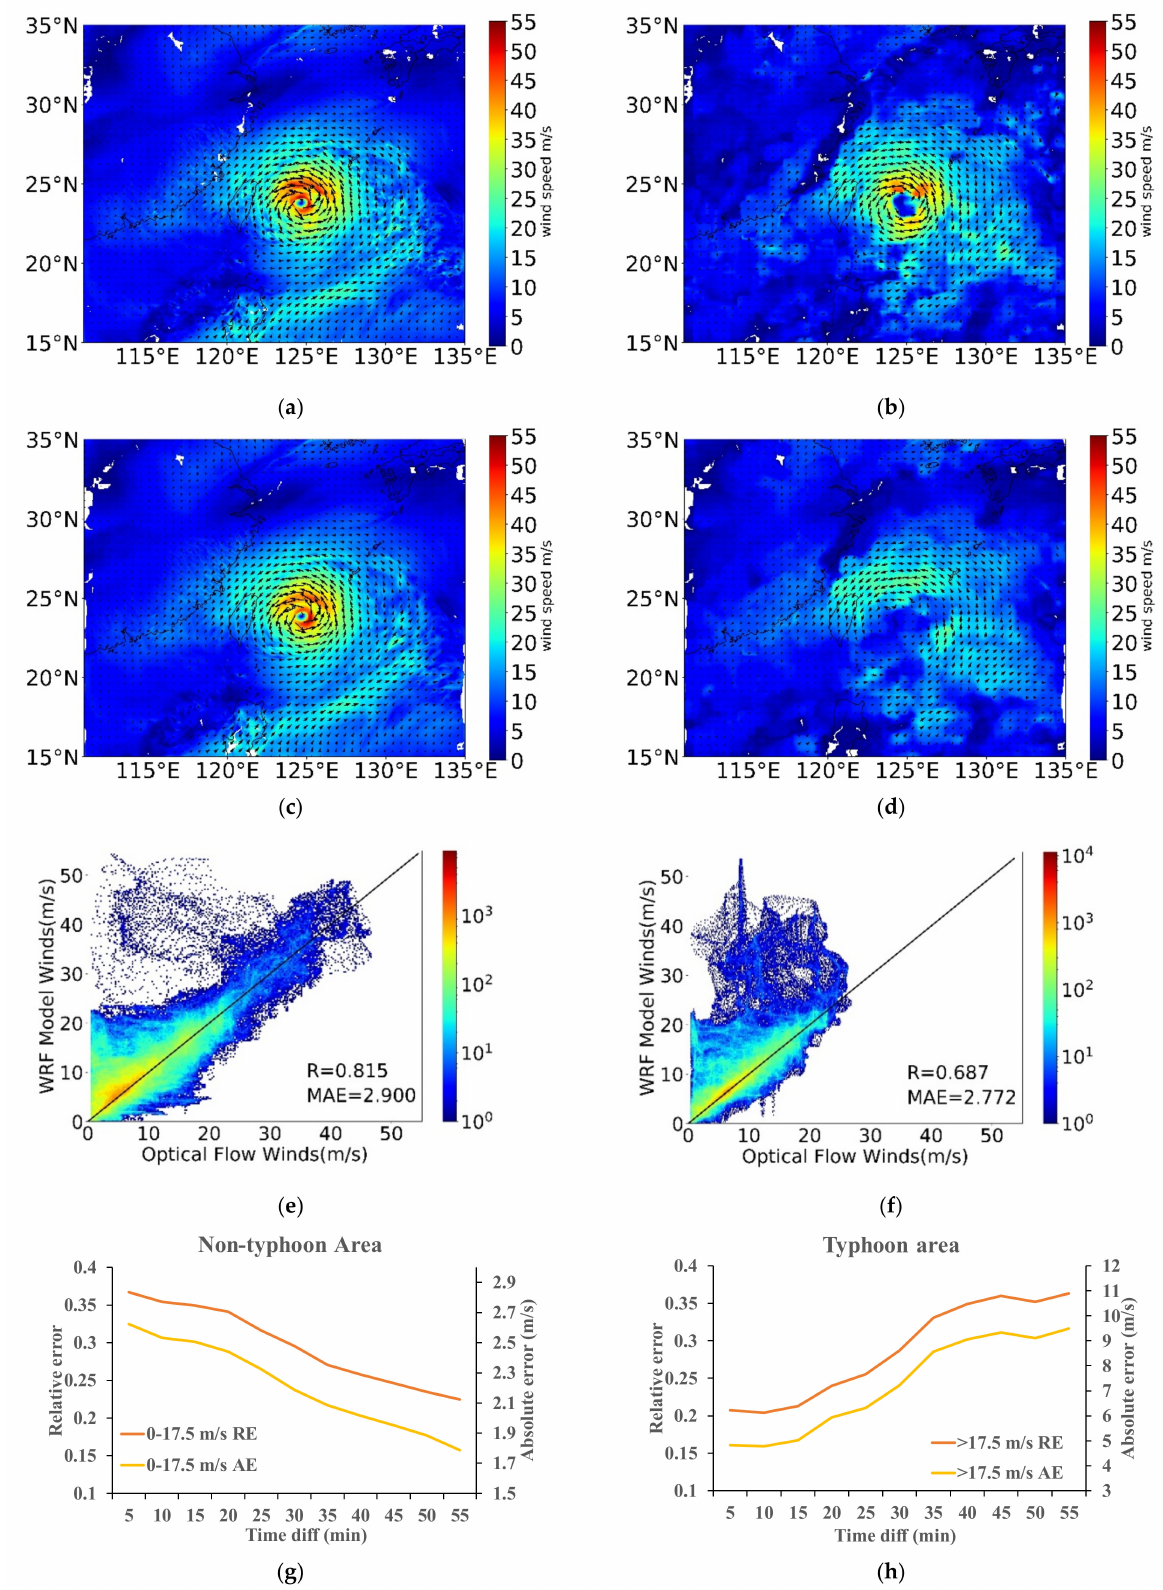
Figure 8. WRF wind field at 400 hPa with the revisiting time of 5 min ( a ) and 50 min ( c ). Farneback wind field at 400 hPa with the revisiting time of 5 min ( b ) and 50 min ( d ). The background color shows the wind speed. Comparison of two wind fields with the revisiting time of 5 min ( e ) and 50 min ( f ). The X- and Y-axis of ( e , f ) represent OF and WRF wind speed, respectively. The wind speed RE (primary Y-axis) and AE (secondary Y-axis) of non-typhoon area ( g ) and typhoon area ( h